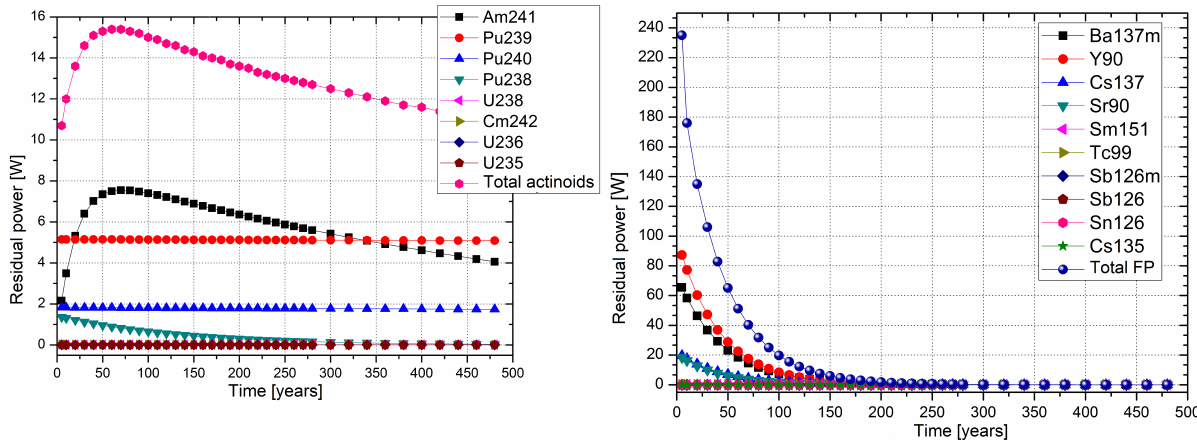
Figure 2. Residual heat generated in the WWER SNF by the most significant actinides (left) and fission products (right) for the first 500 years after discharge from a reactor. It was calculated using ORIGEN-ARP decay code, with cross-section libraries generated using 2-D depletion module TRITON from the SCALE package for a reference condition of WWER-440 fuel as recommended by [34–36].